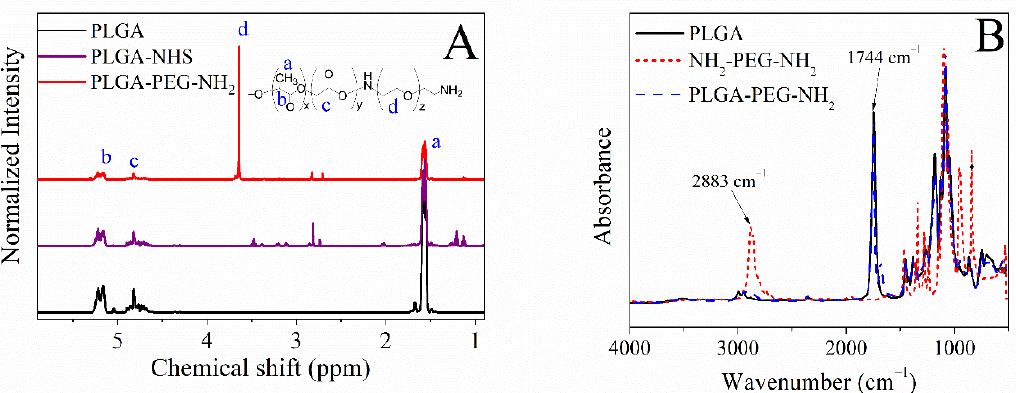
Figure 2. ( A ) 1 H-NMR spectra of the PLGA, activated PLGA and diblock copolymer PLGA-PEG-NH 2 , and ( B ) FTIR spectra of PLGA, PEG diamine, and synthesized diblock copolymer PLGA-PEG-NH